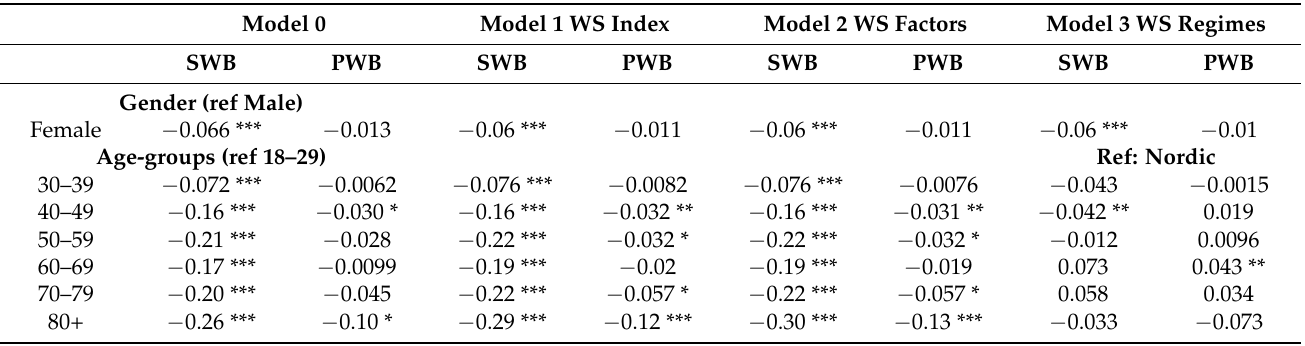
Table 2. Results from multilevel regressions predicting subjective wellbeing (SWB) and psychological wellbeing (PWB) by three welfare state approaches (Model 1, WS index; Model 2, WS factors; Model